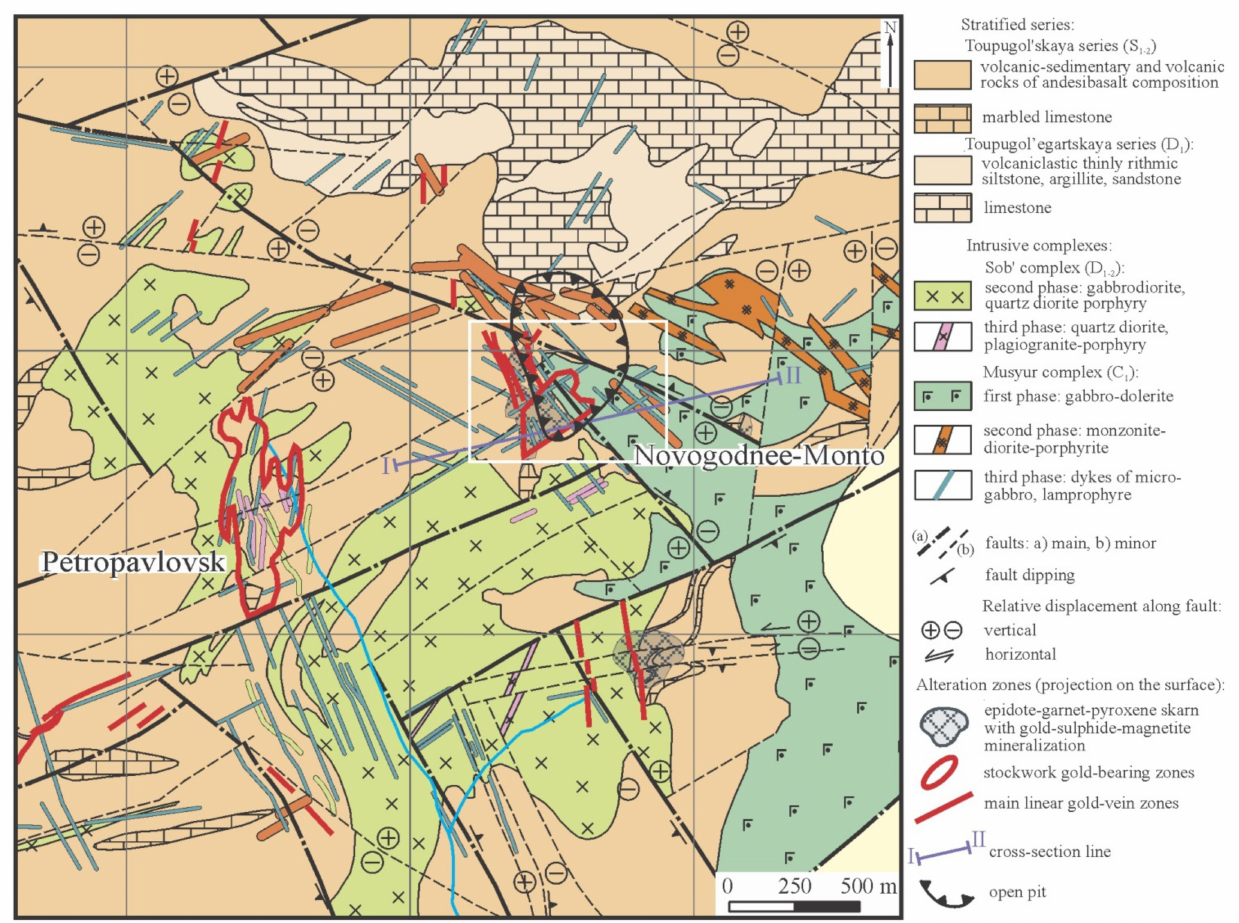
Figure 2. Geological map of the Novogodnee gold field, compiled using data in Reference [43] and JSC “Yamalgold”, simplified after [45]. The white box outlines the boundaries of the geological map illustrated in Figure